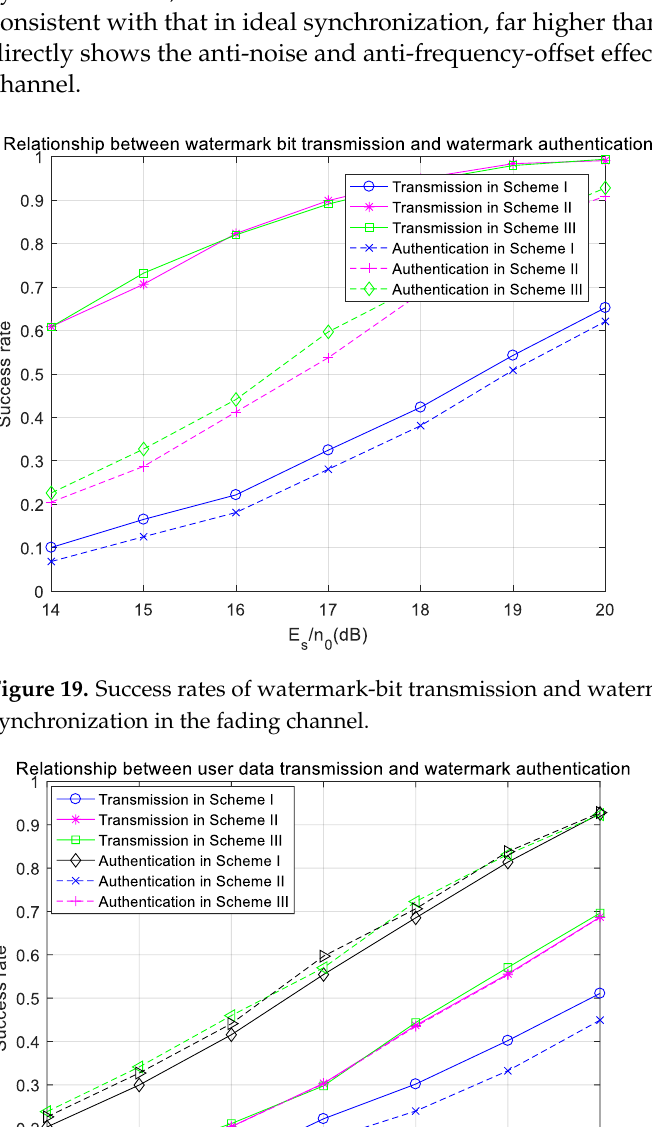
19 of 22 Figure 18. Success rates of user-data transmission and watermark authentication under ideal syn-